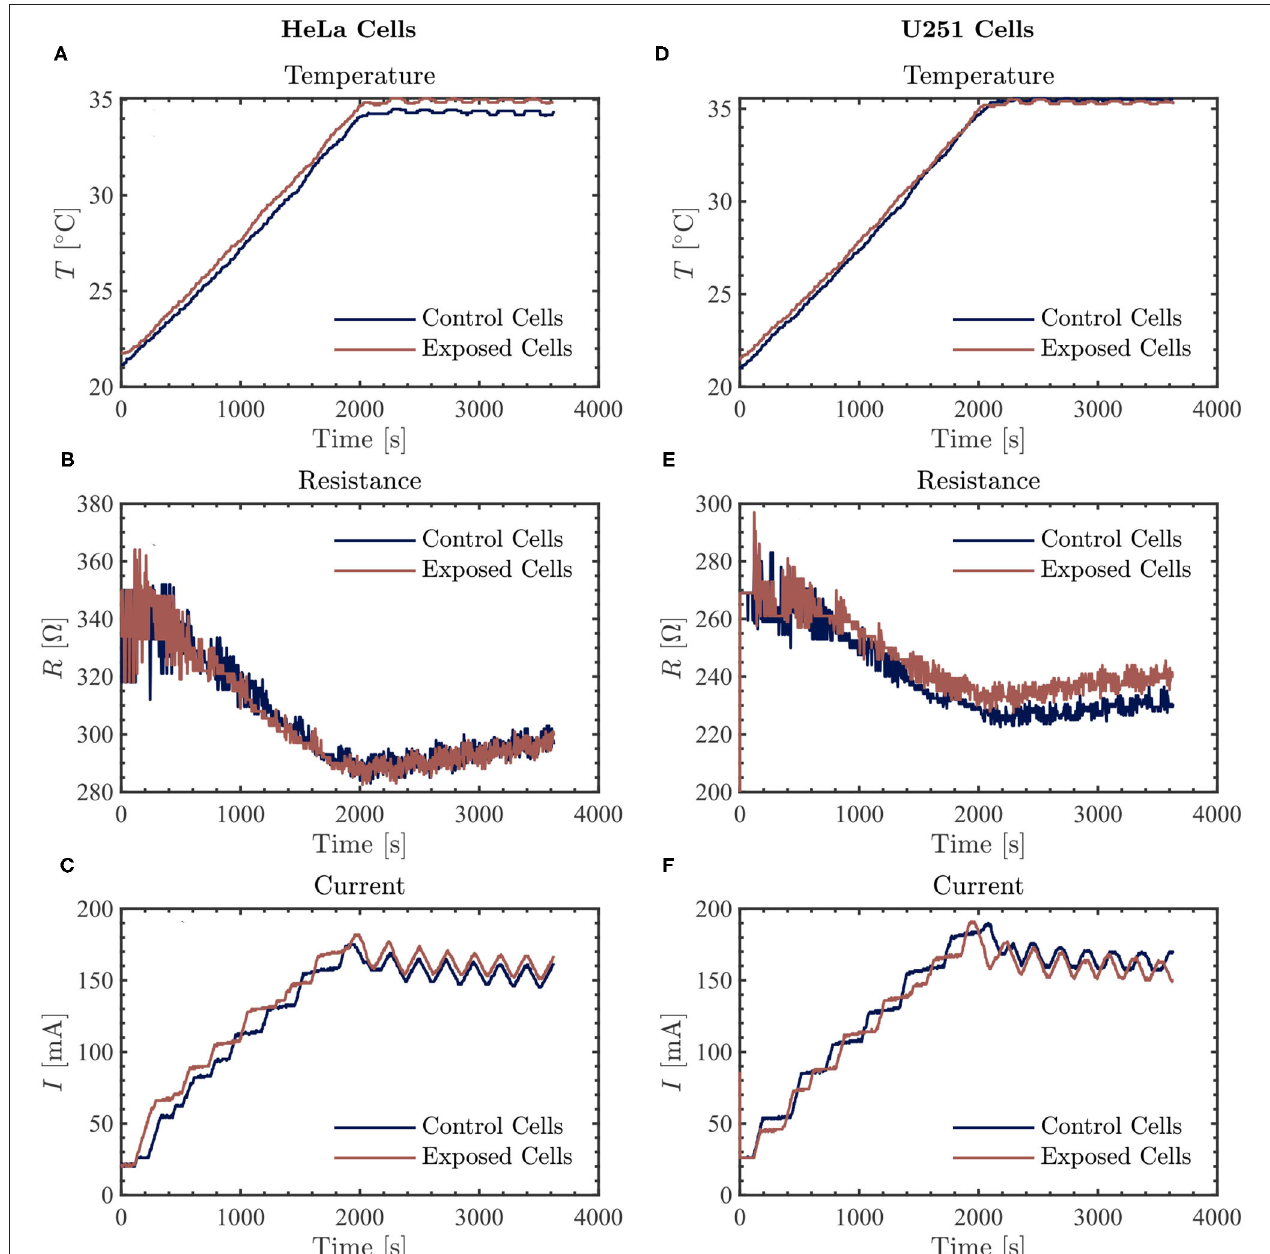
FIGURE 4 | The resulting average temperature (top), resistance (middle), and current (bottom) graphs measured by the inovitro live software for 100 kHz TTFields applied to HeLa (left, A–C ) and U251 (right, D–F ) cells in the absence (control) or presence of Vielight LED exposure for 1 h with the software settings as described in the text. The control and Vielight LED-exposed results are shown in blue and red, respectively. Data shown for both cell lines are taken from a single independent experiment out of N = 2 total replicate experiments